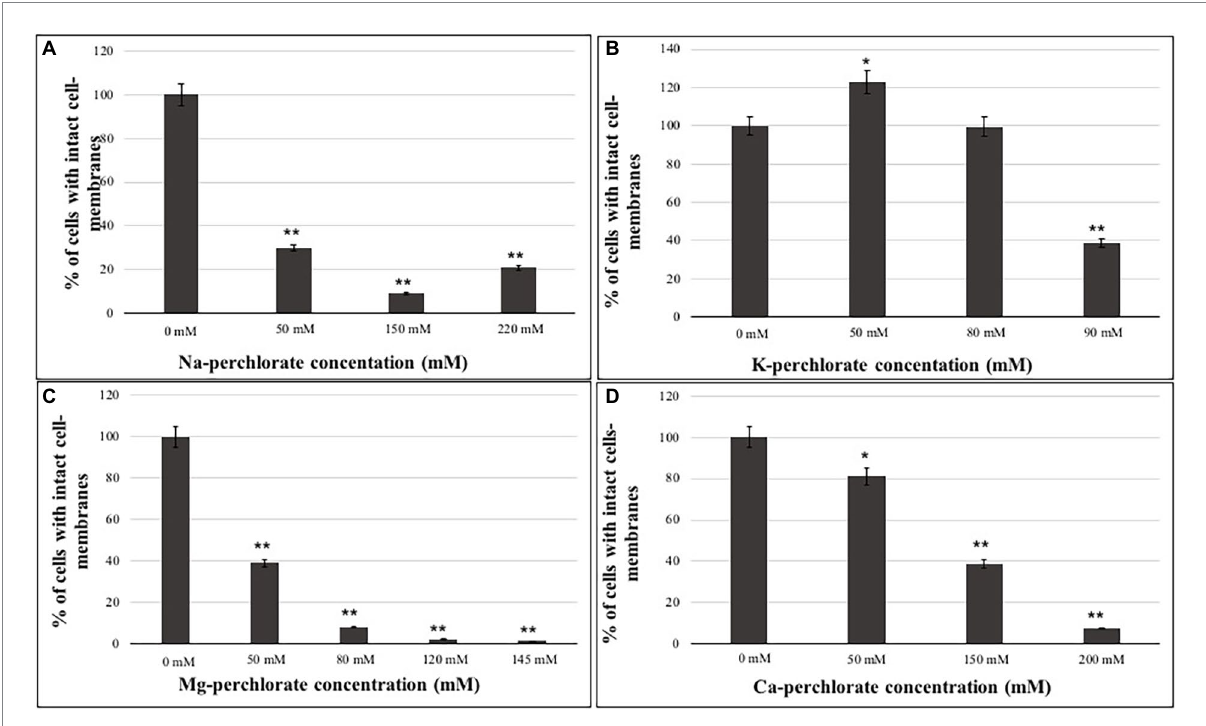
FIGURE 3 Percentage of cells with intact cell-membranes measured with PMA assay coupled with qPCR of C. antarcticus colonies grown on different perchlorates concentrations. (A) Na-, (B) K-, (C) Mg-, and (D) Ca-perchlorates. All concentrations are expressed in mM. Significant differences were calculated through t test, by comparing 0 mM (Ctr) and the different perchlorate concentrations with * = p < 0.05 and ** = p < 0.001.